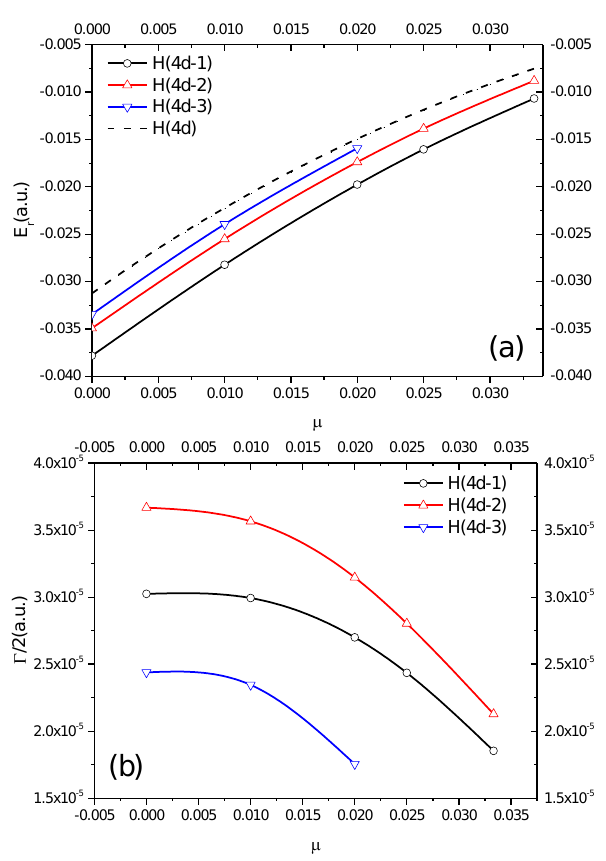
Figure 4. D -wave ( a ) resonance energy and ( b ) half-width for the H (4d- k ) states with k = 1, 2, 3 as a function of μ = 1/ D .